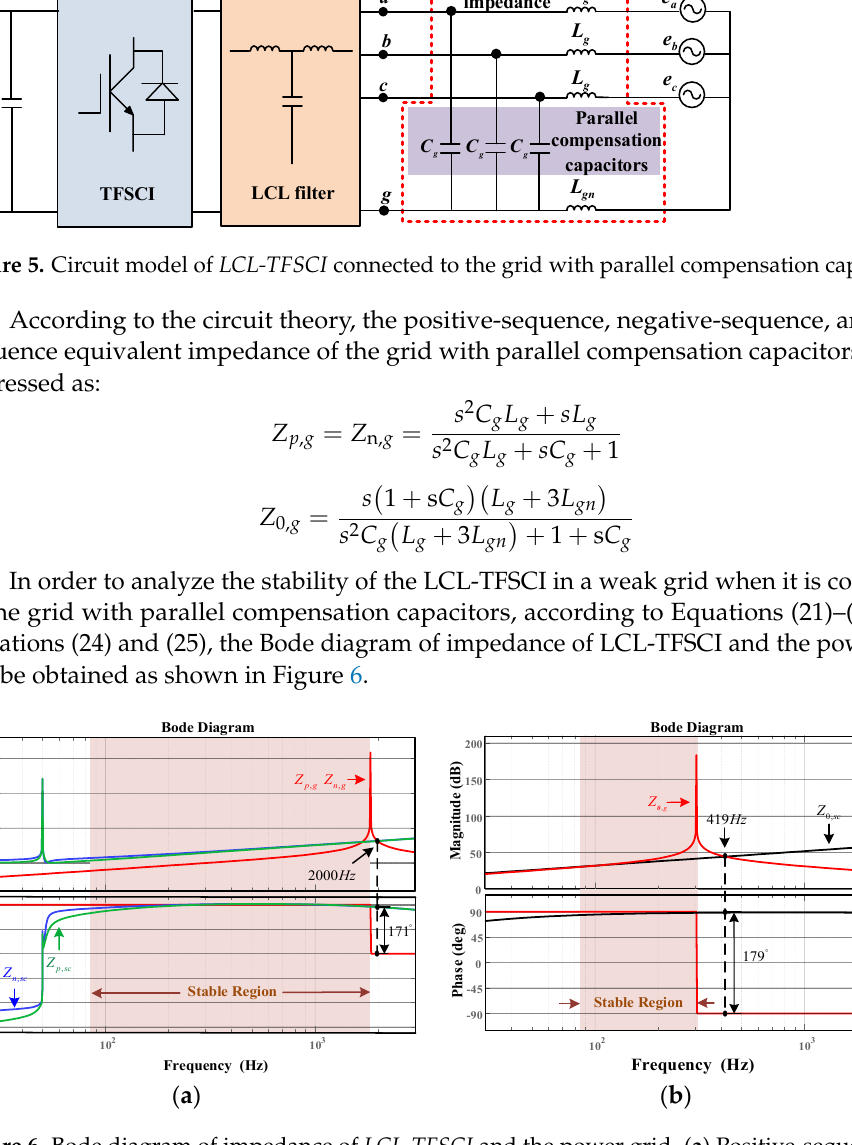
Figure 6. Bode diagram of impedance of LCL-TFSCI and the power grid. ( a ) Positive-sequence and negative-sequence; ( b ) Zero-sequence.